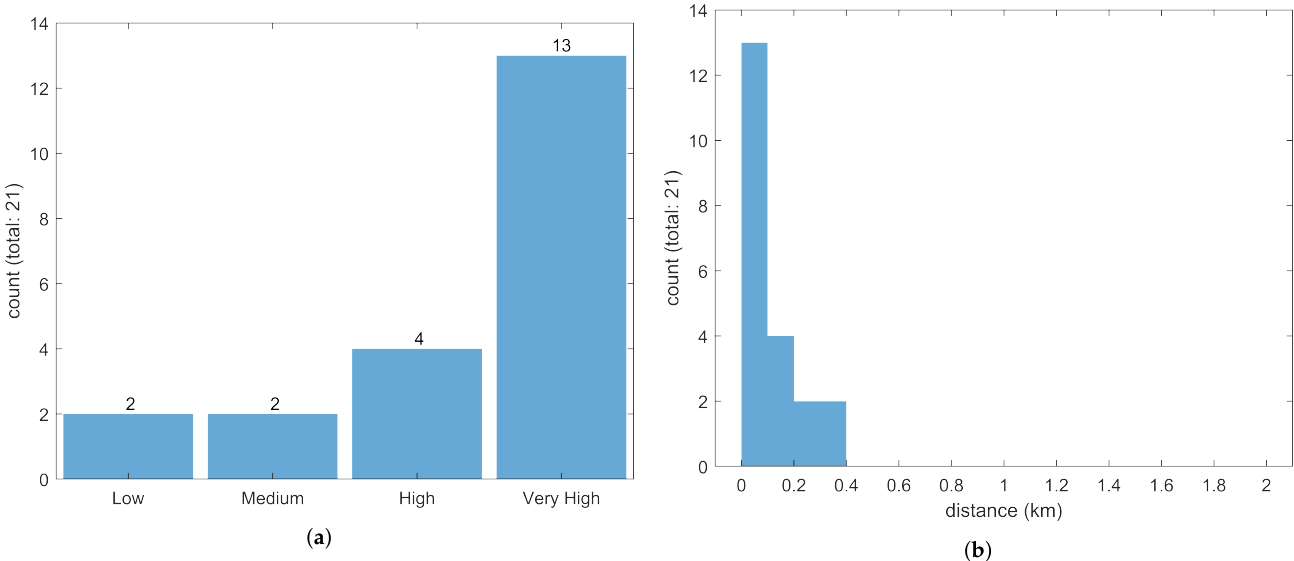
Figure 19. The Solent ( a ) AIS-SAR assignment confidence levels and ( b ) distribution of assignment